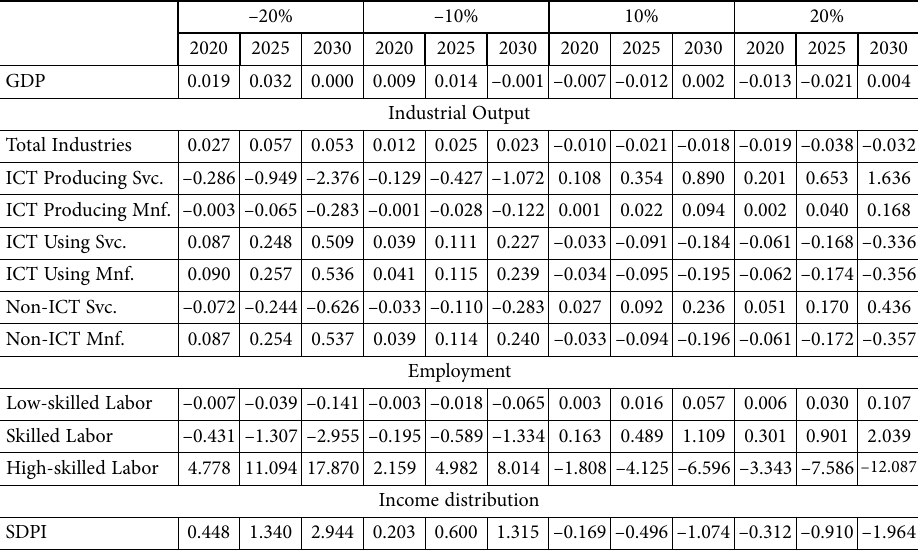
Table B3. Major variables under alternative elasticity of substitution between capital composite and high-skilled labor ( s